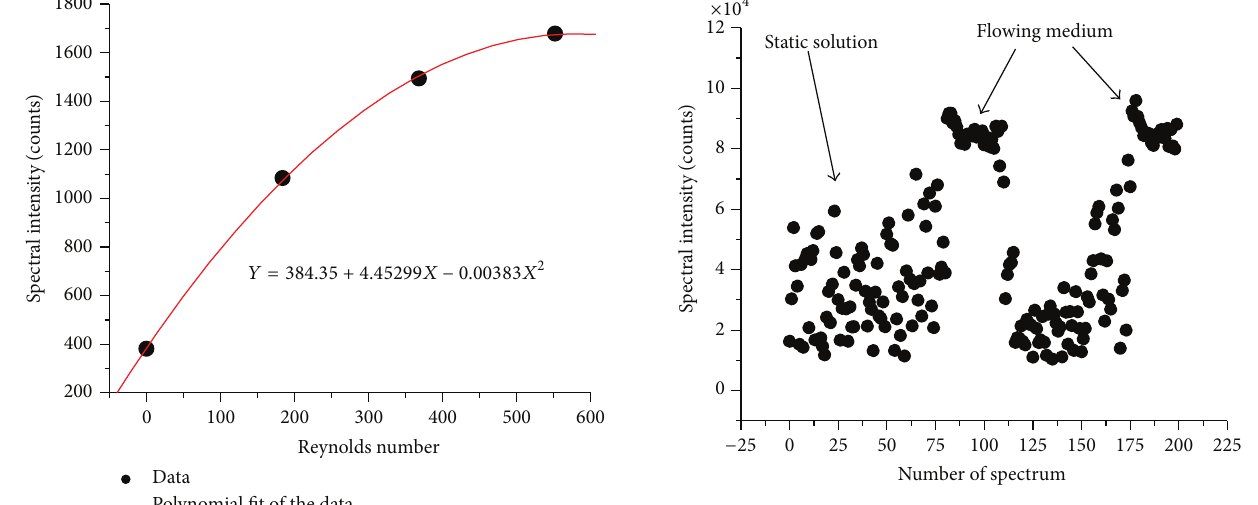
Figure 5: The spectral intensity variation of fluorescence emission in static and flowing dye